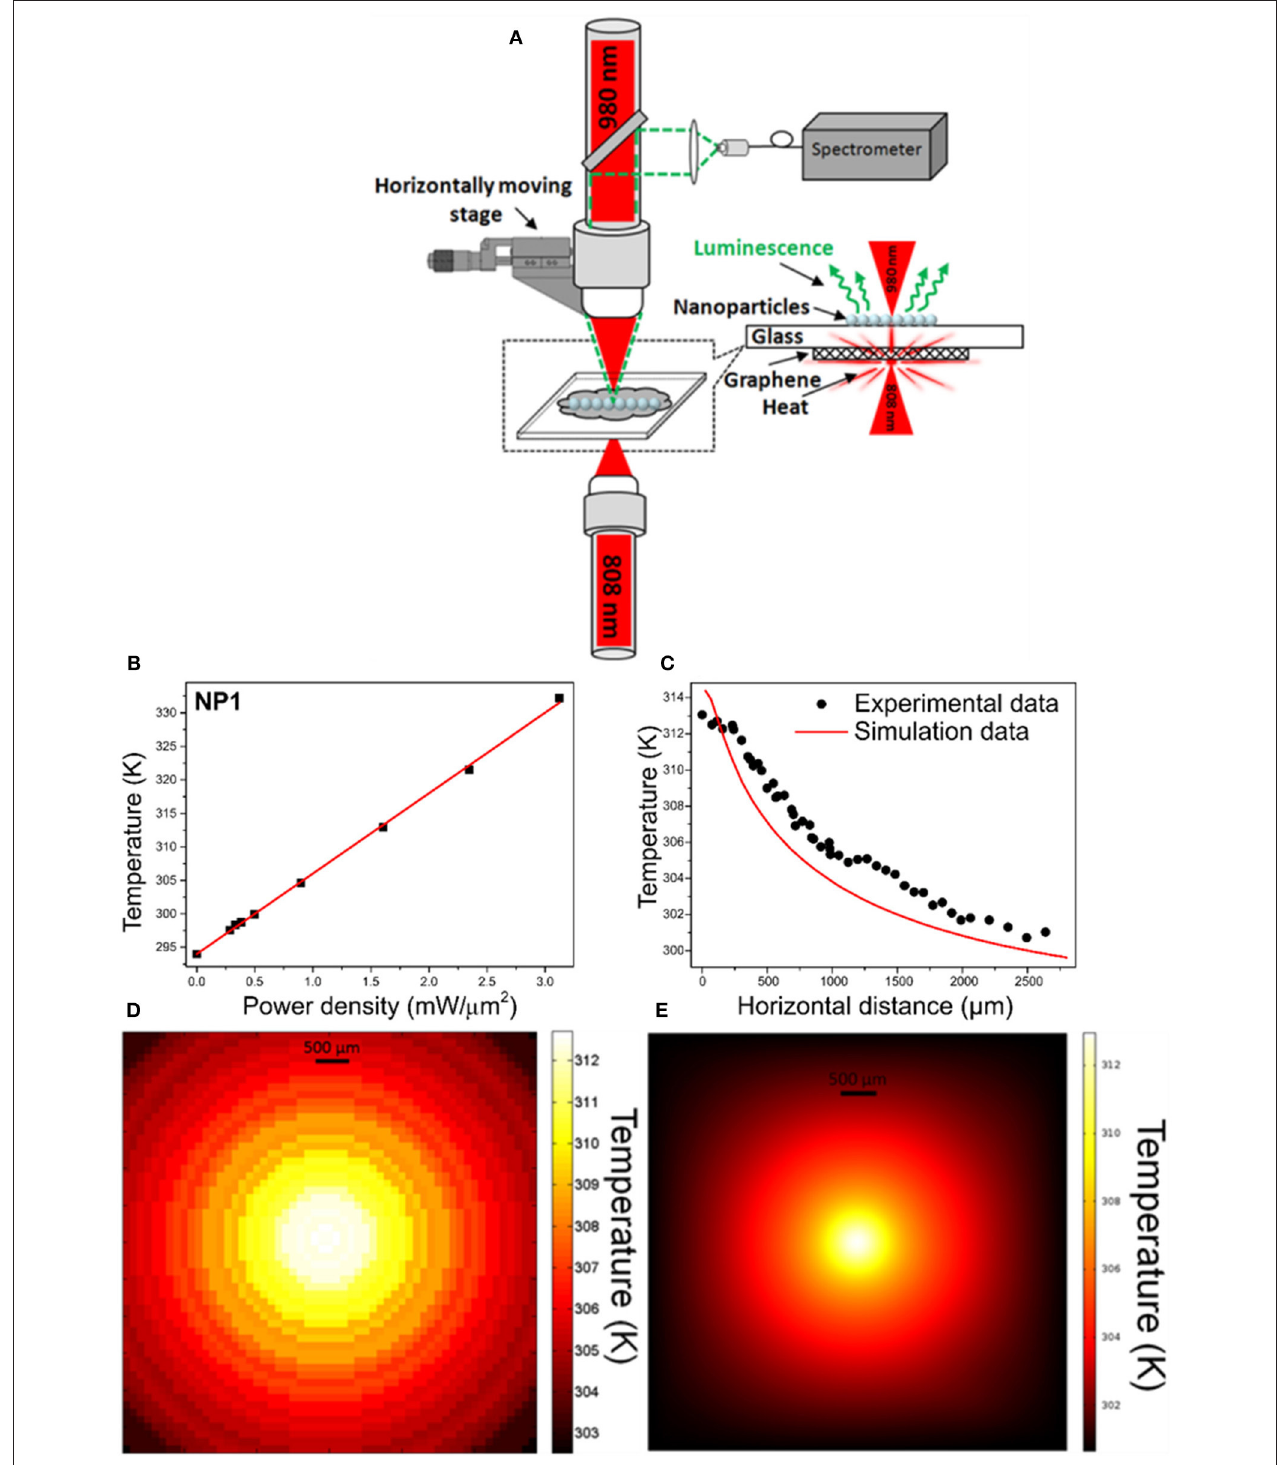
FIGURE 3 | (A) Scheme of the setup used to map the temperature distribution generated by graphene when illuminated with a 808nm laser on a microscope slide cover glass. (B) Temperature achieved on the surface of the graphene-coated glass as a function of the power of the irradiating laser at 808nm. (C) Temperature distribution generated by graphene on the slide cover glass determined from the luminescence spectra of the Er,Yb:NaYF 4 nanoparticles and comparison with the temperature distribution calculated from a heat transfer model in a 3D geometry. 2D temperature contour map generated from the data obtained (D) experimentally, and (E) with the 3D